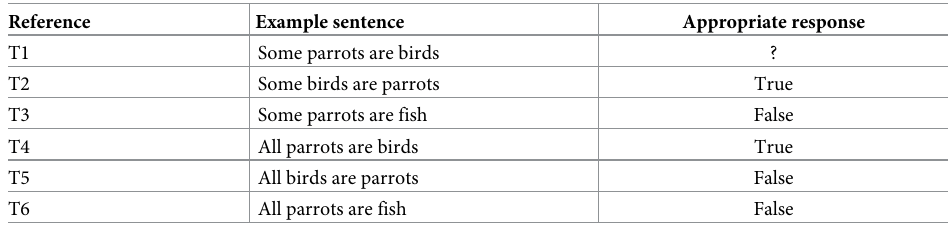
Table 1. Examples of test